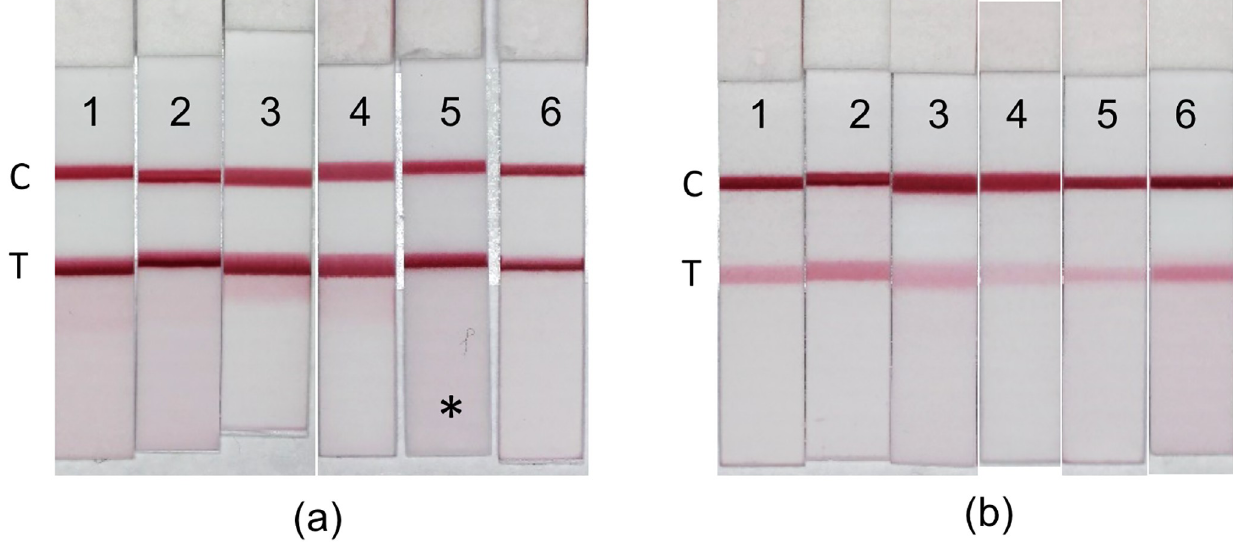
Fig 3. Visual representation of the lateral flow immunoassay (LFIA) half strips. Test (T) line coating antigens were (a) LB-AMA BSA and (b) PERI-AMA-BSA immobilized onto six different nitrocellulose membrane types: (1) MDI 150, (2) FF120, (3) FF80, (4) MDI 90, (5) CN95, and (6) CN140. ( � ) designates the preferred membrane used in the remaining